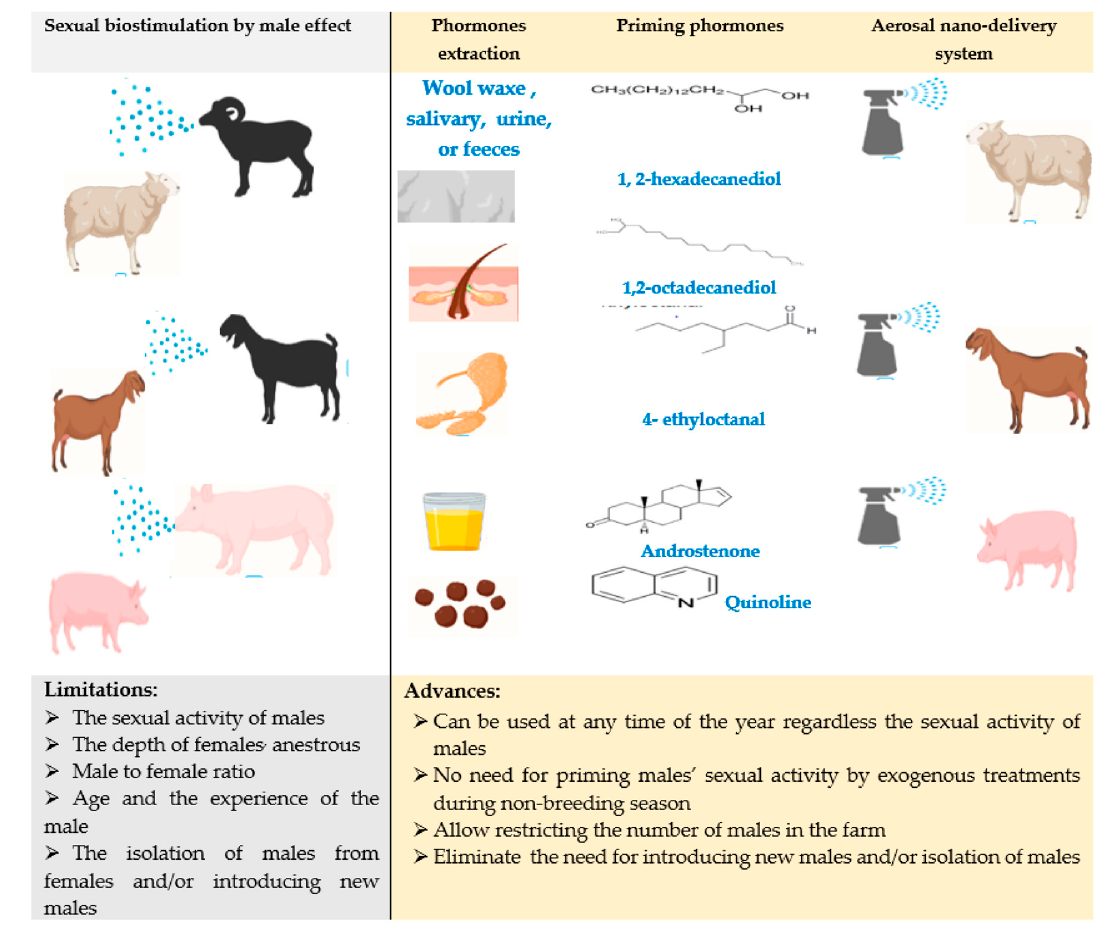
Figure 1. Possible applications of an aerosol nano-delivery system in pheromones-dependent sexual bio stimulation (male